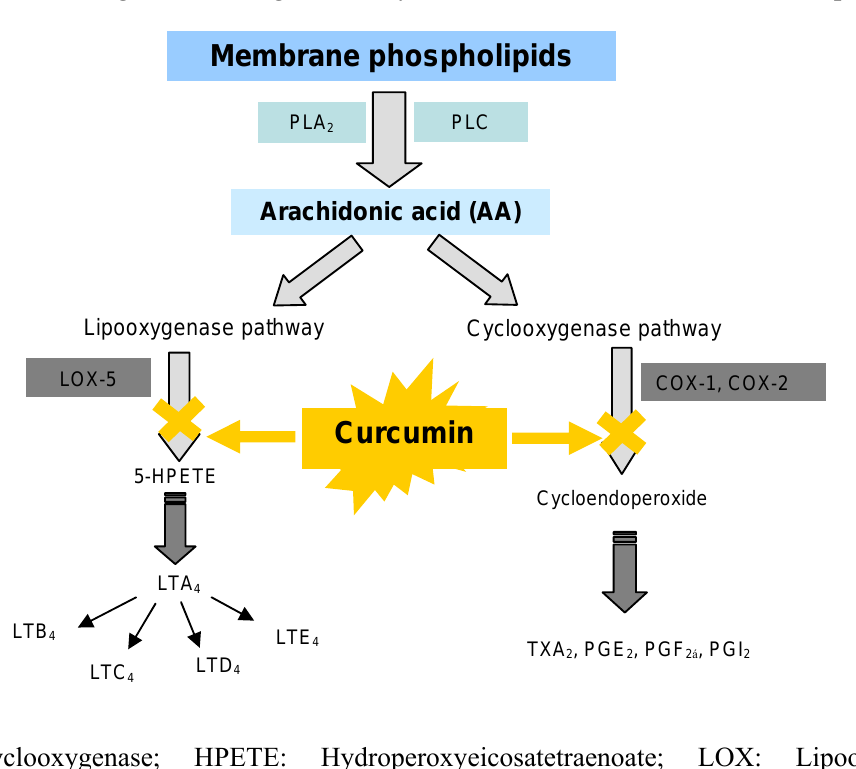
Figure 5. Flow diagram showing inhibitory effect of curcumin on arachidonic